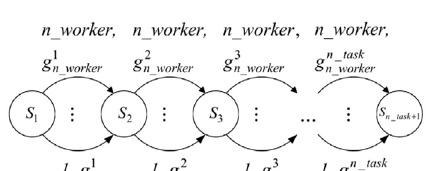
Figure 1. The location of tasks in a